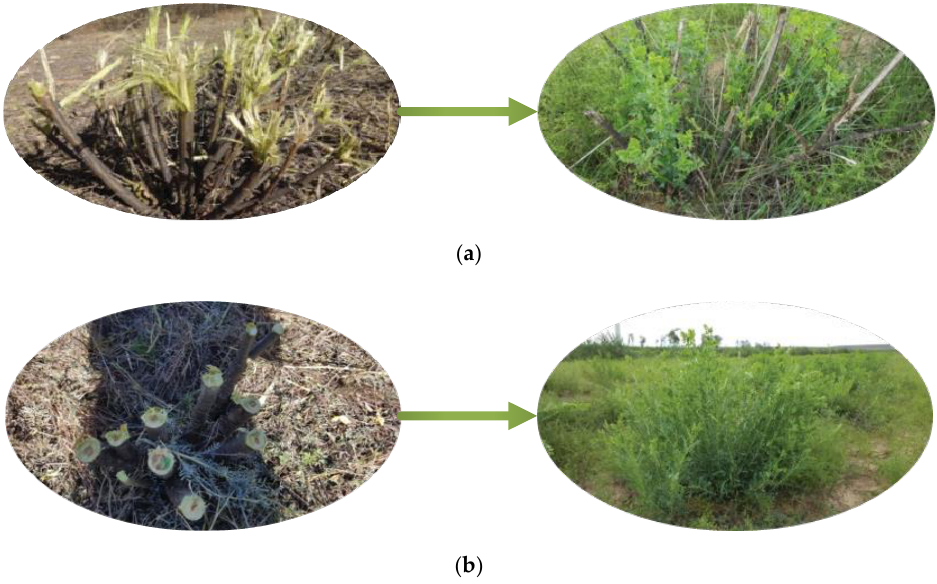
Figure 2. Stubble cross-sections of C.K. and germination rate the following year (( a ) Burr cross-section germination rate in the following year; ( b ) Flat cross-sections germination rate in the following year). To facilitate analysis and measurement, the sawing quality of the cross-section (broken area as a percentage of the area of the branch cross-section) is determined using the broken area ratio τ [38,39]. The area of the branch cross-section as well as the area of the damaged part was extracted by Matlab software, as shown in Figure 3.